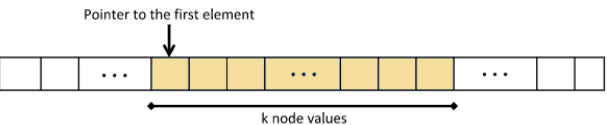
Figure 5. Ordering of tree